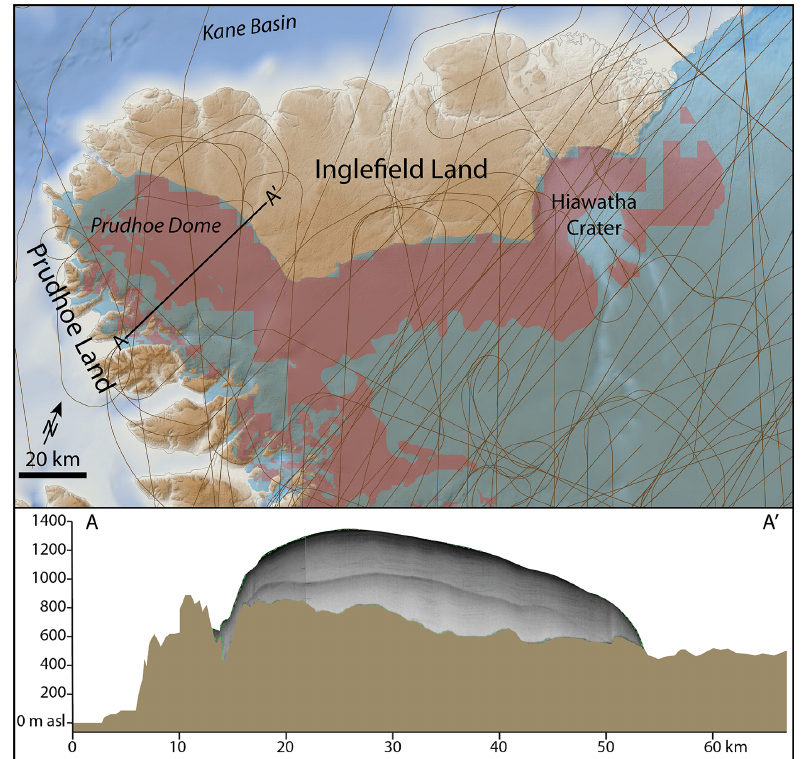
Figure 5. Top panel shows areas that meet drilling requirements (shown in red) in NW Greenland. The Greenland Ice Sheet is depicted in light blue, and NASA Operation IceBridge (OIB) flight lines are shown as thin brown lines. Bottom panel shows OIB radar of Prudhoe Dome along A–A (cid:48) , with topography, the ice-sheet bed and the ice-sheet surface from radar collected in 2017; the mid-ice-sheet reflector is the surface multiple. Basemap topography and bathymetry from Morlighem et al.